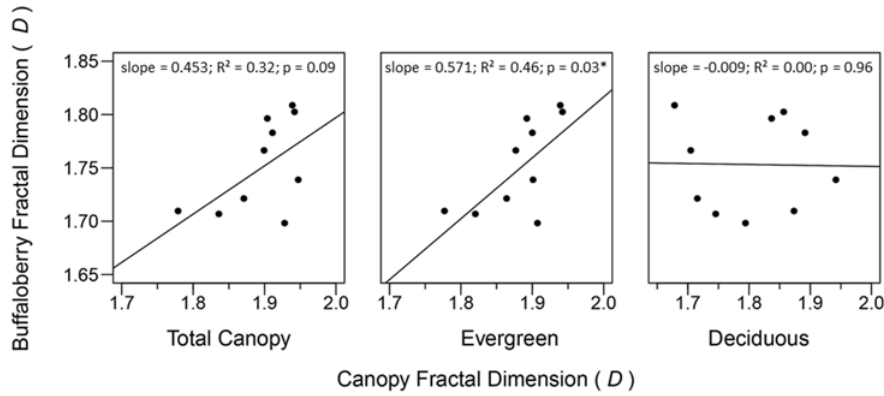
Figure 6. General linear models describing relationships between fractal dimensions of buffaloberry shrubs and forest canopy categories. Asterisks indicate a significant effect ( α = 0.05). 95% confidence intervals for coefficient estimates of total canopy, evergreen, and deciduous categories were ( − 0.091, 0.996), (0.064, 1.078), and ( − 0.401, 0.383), respectively.